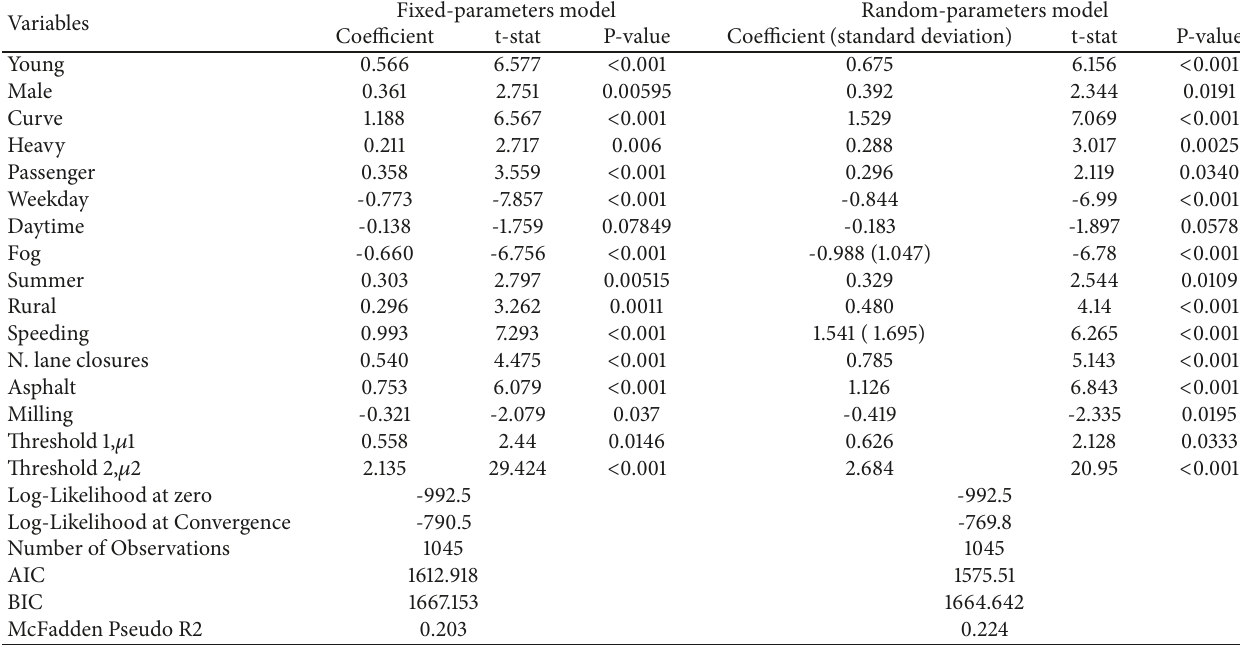
Table 2: Rear-end injury severity model results.